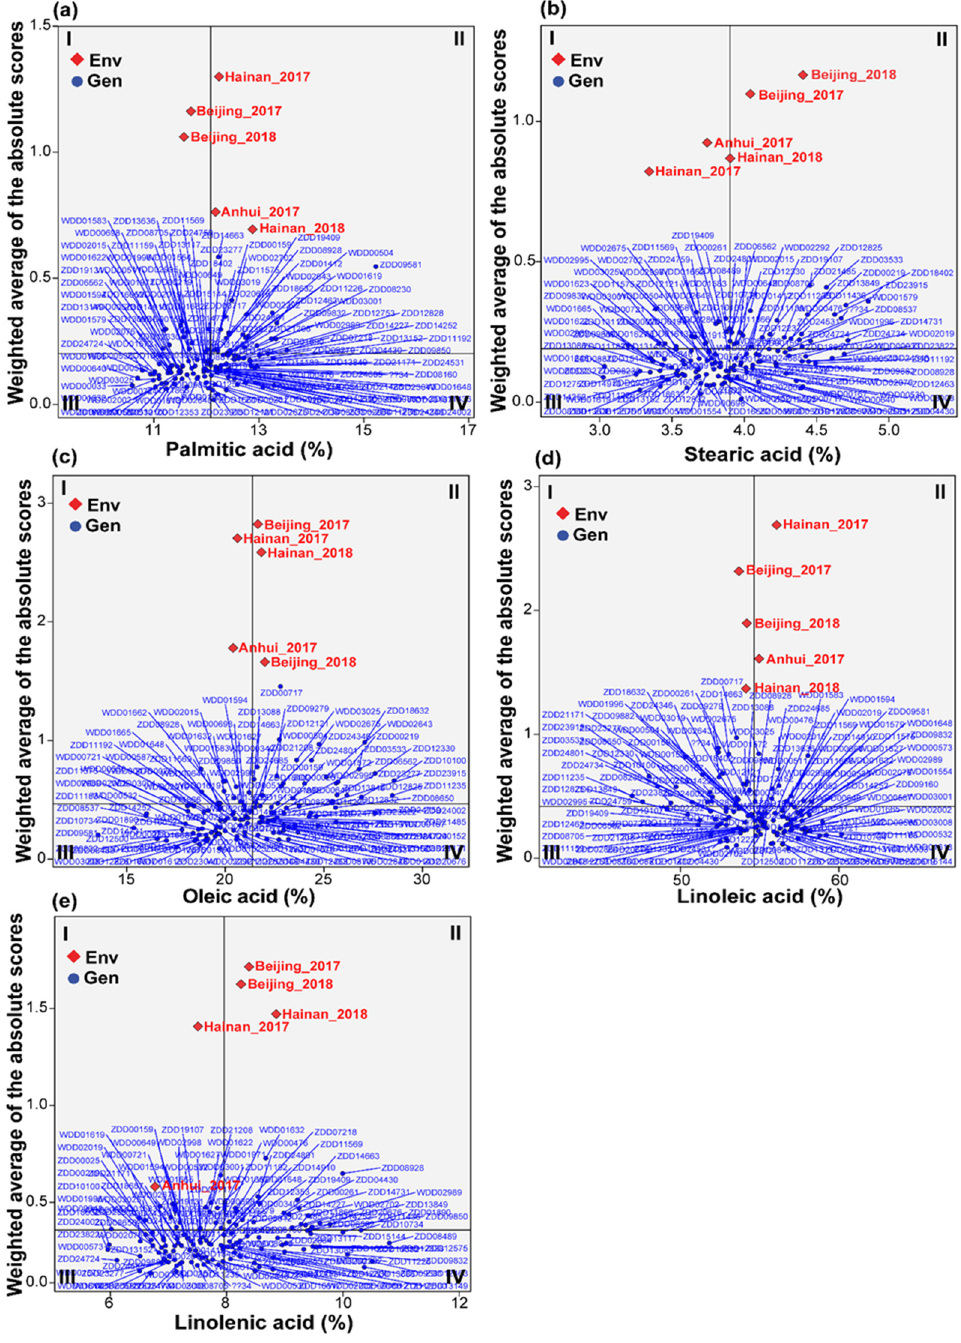
Figure 2. Biplots showing the performance vs. stability of 135 soybean genotypes for palmitic acid ( a ), stearic acid ( b ), oleic acid ( c ), linoleic acid ( d ), and linolenic acid ( e ). The x -axis shows the arithmetic mean for each genotype × environment interaction. The y -axis shows the weighted average of absolute scores from the singular value decomposition of the matrix of best linear unbiased predictions for the genotype × environment interaction effects.